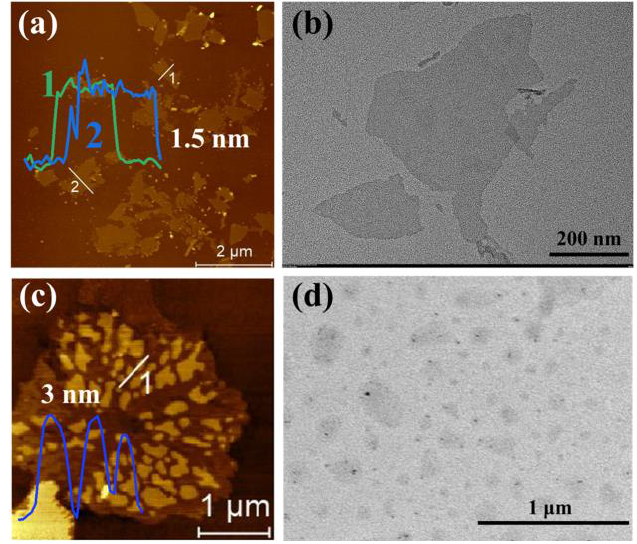
Figure 1. Morphological characterizations of Ti 3 C 2 nanosheets and self-assembled PNSs: ( a ) AFM image of Ti 3 C 2 nanosheets, the number and color line in green and bule corresponding to the thickness of 1 and 2 samples respectively; ( b ) TEM image of Ti 3 C 2 nanosheets; ( c ) AFM height image of PNSs; ( d ) TEM image of